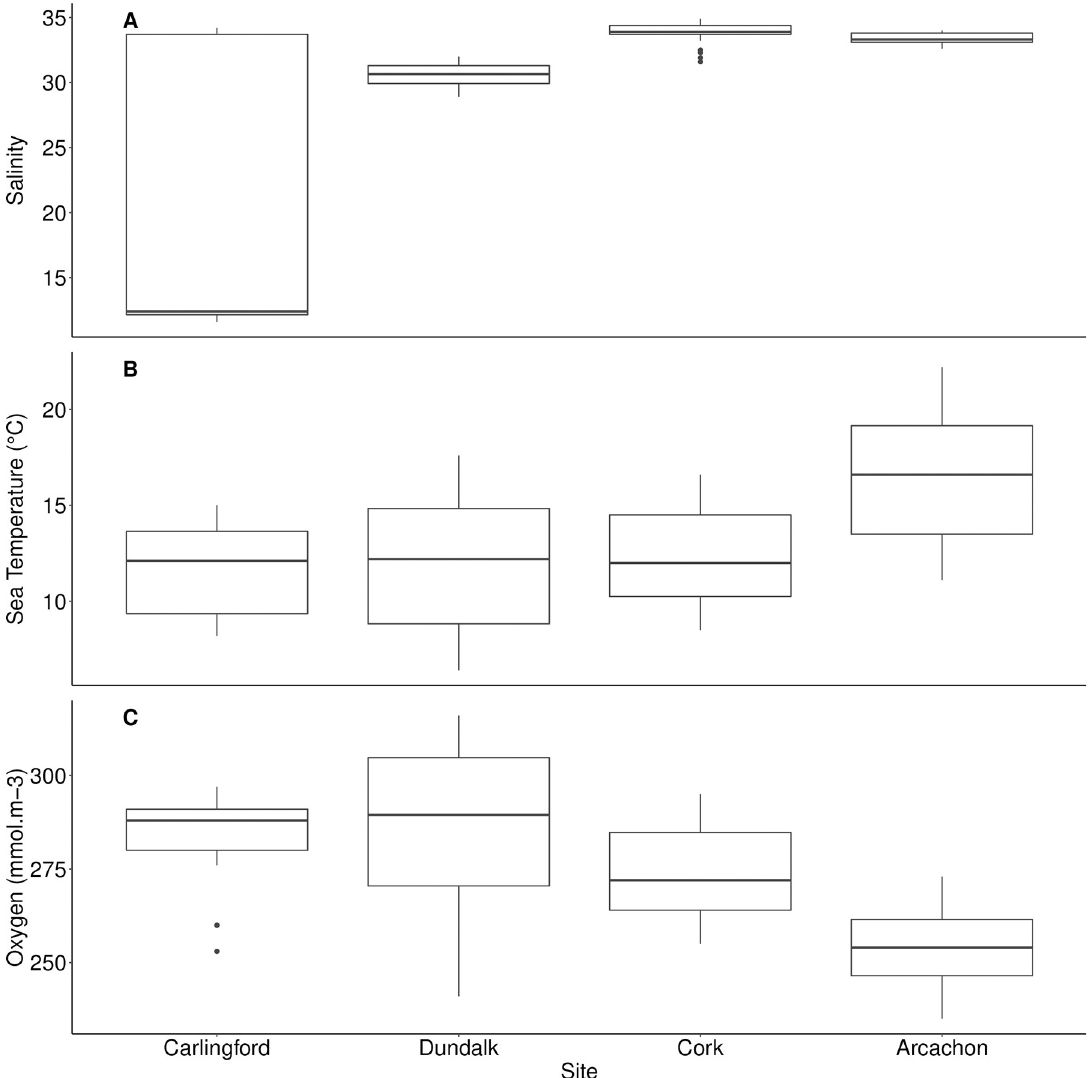
Fig 4. Boxplots describing differences in (A) salinity, (B) sea temperature and (C) dissolved oxygen for each of the sites surveyed for histological analysis of Cerastoderma edule . The boxplots display the median values, with boxes extending from the 25 th to 75 th percentile of each group’s distribution of values, and whiskers demonstrate the largest and smallest values within 1.5 times the interquartile range. Outliers are indicated by individually plotted